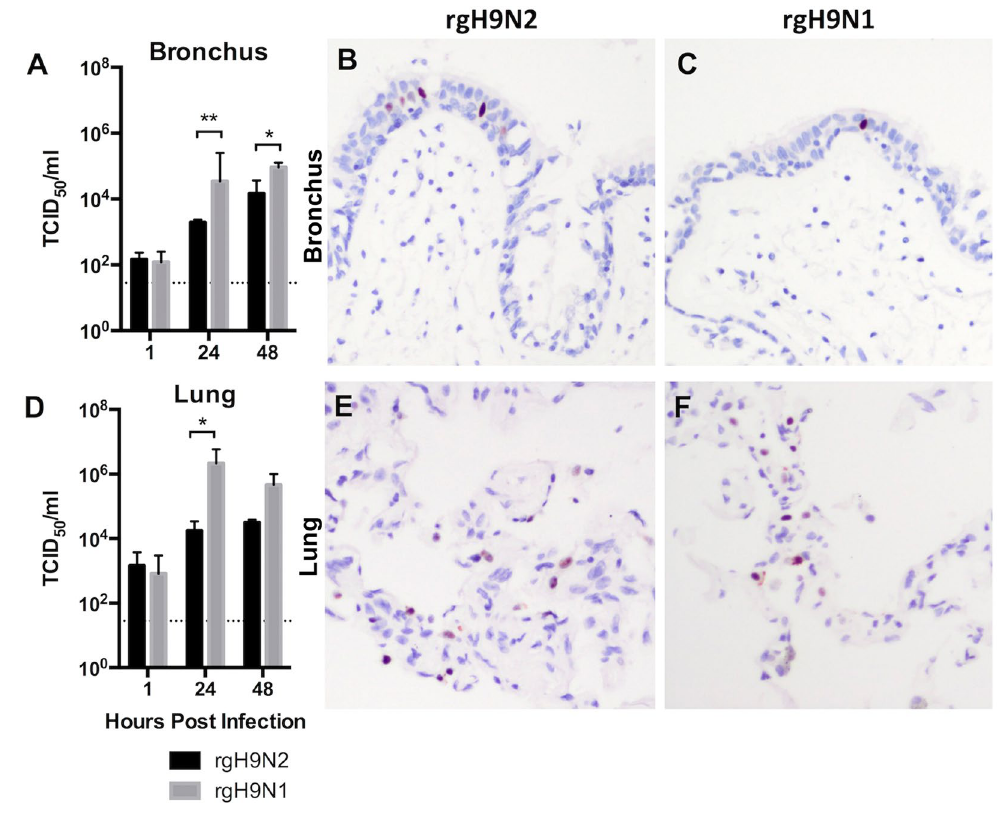
Figure 4. Influence of neuraminidase on H9 virus replication. Replication in the ( A – C ) bronchus and ( D – F ) lung of reverse genetics H9N2 containing the HA and NA of H9N2/G1 and the internal genes from a pandemic H1N1 virus (A/California/04/2009) (rgH9N2), and a comparing virus with only HA of H9N2/G1 and the other seven genes from (A/California/04/2009) (rgH9N1). The chart showed the mean and the SEM of the virus titer pooled from at least three independent experiments. Asterisks indicated statistical significant increase in viral yield at the same time point between the two virus using paired student t -test. * p < 0.05; ** p <